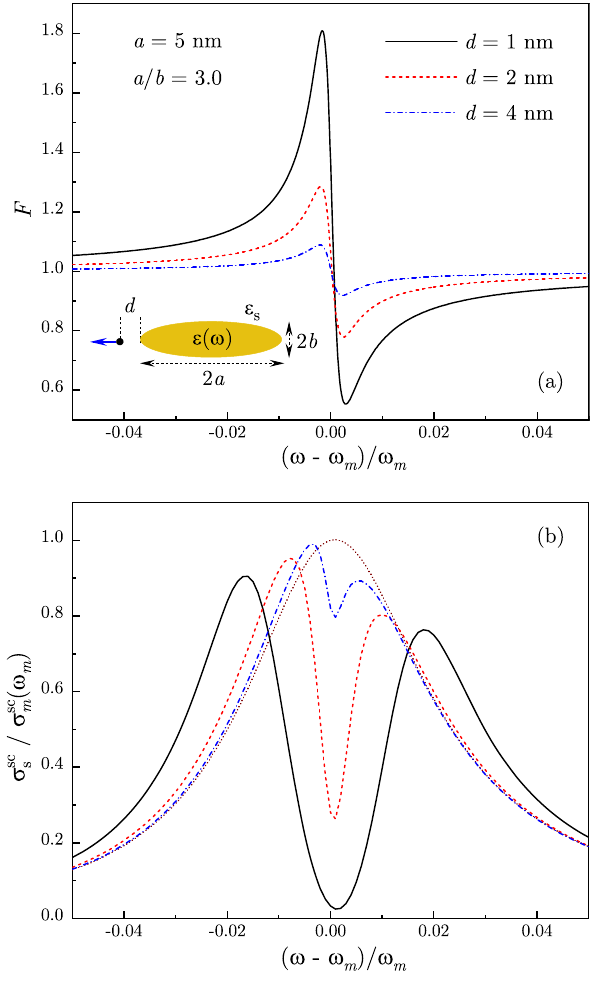
Figure 4: (a) The Fano function F ( 𝜔 ), given by Eq. (31), is shown for a QE near the tip of Au nanorod with aspect ratio a ∕ b = 3 . 0 and length 2 a = 10 nm at distances d = 4, 2, and 1 nm. (b) Normalized scattering cross-section, given by Eq. (36), is shown for the same system parameters. The dotted line is the plasmon band. All curves = 𝜔 . Inset: schematics of a QE situated at a are calculated for 𝜔 e m distance d from the tip of Au nanorod in water for QE dipole moment oriented along the nanorod